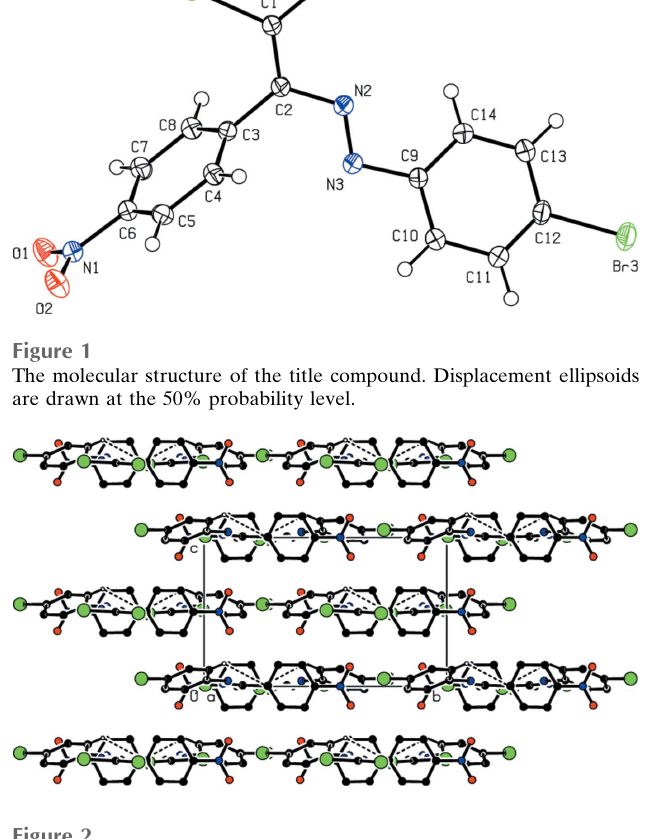
Figure 2 View down the a -axis of the title compound showing the C—H (cid:2)(cid:2)(cid:2) Br interactions.